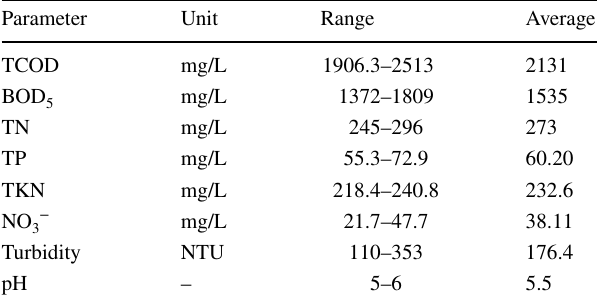
Table 1 Milk processing wastewater characteristics